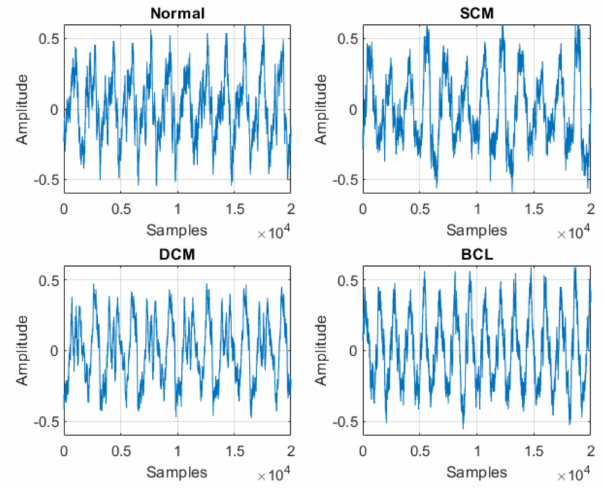
Figure 20. Samples of the studied signals—Normal, SCM, DCM and BCL.